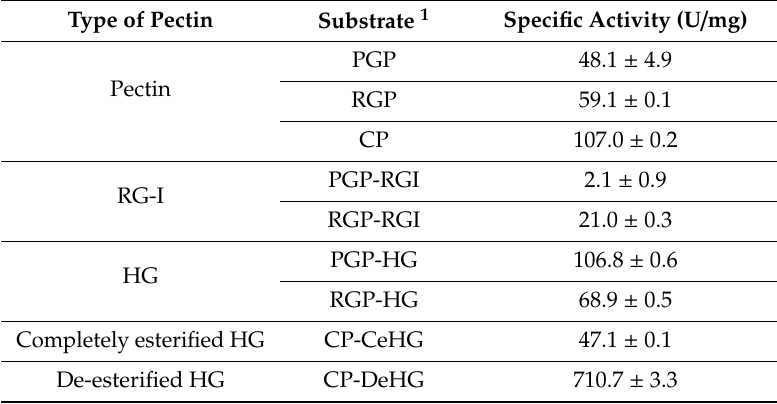
Table 2. Degradation of various pectins by